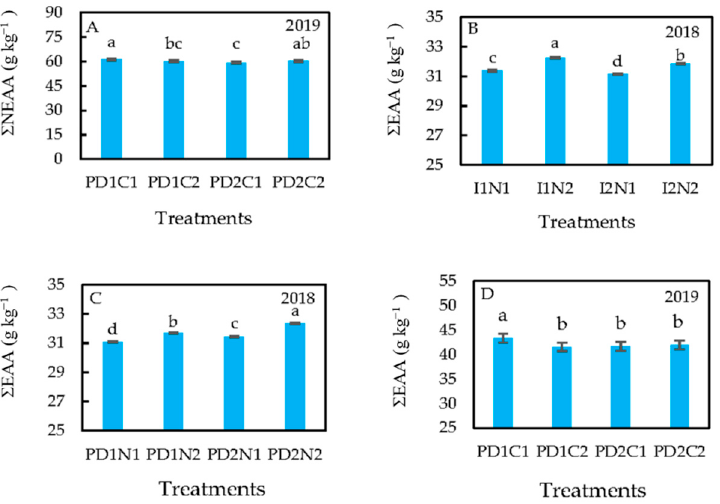
Figure 5. Least square means of maize grain for total nonessential amino acids ( Σ NEAA) in response to interaction effects of planting date and cultivar ( A ) and least square means of maize grain total essential amino acids ( Σ EAA) in response to interaction effects of irrigation and nitrogen ( B ), planting date and nitrogen ( C ), and planting date and cultivar ( D ). I1, irrigation at 12-day intervals; I2, irrigation at 6 day-intervals; PD1, planting date 21 June; PD2, planting date 22 July; C1, KSC704; C2, KSC260; N1, 0; N2, 184 kg N ha − 1 . Least square means labelled with the same letter do not differ significantly at p < 0.05 based on Tukey’s test. Vertical bars represent the 95% con- fidence interval.